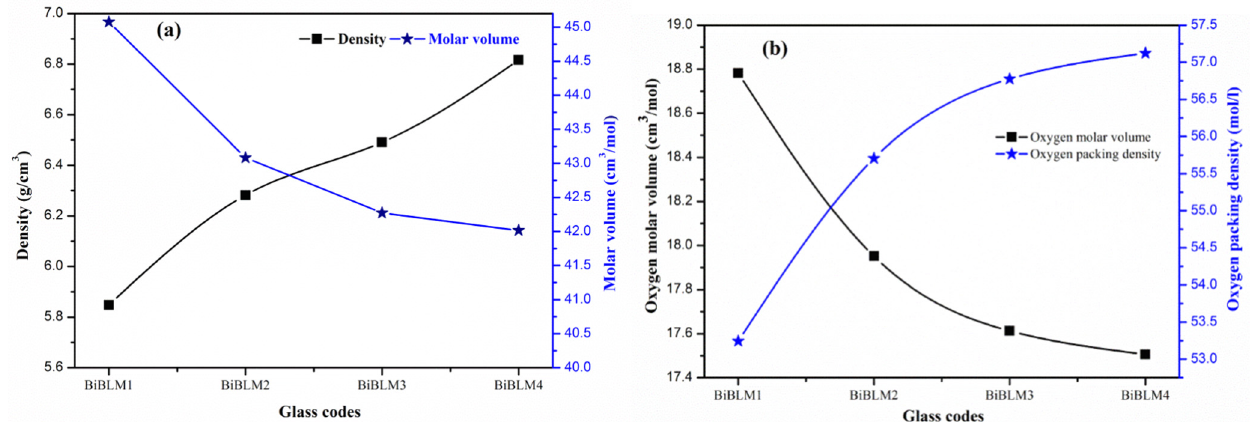
Figure 1. Association between ( a ) density ( ρ ) and molar volume ( V m ), ( b ) oxygen molar volume ( V o ) and oxygen packing density (OPD) with respect to the corresponding BiBLM glasses.